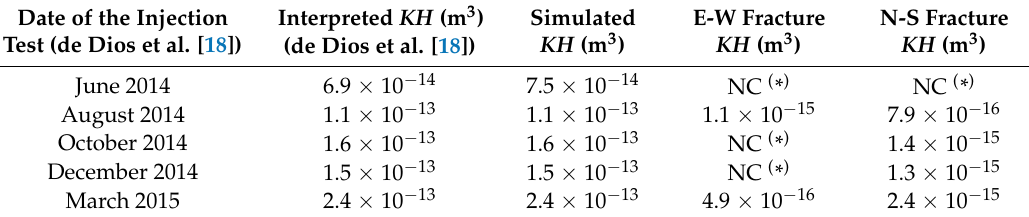
Table 5. Simulated flow capacity in different fall-off tests for HI